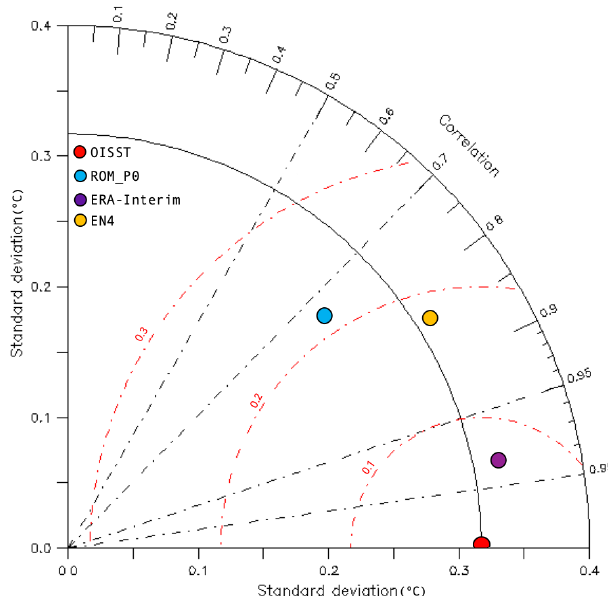
Figure 8. Taylor diagram for Mediterranean SSTs during the 1982– 2012 period. The diagram summarizes the relationship between standard deviation ( ◦ C), correlation ( r ) and RMSE (red lines, ◦ C) for all datasets. The gridded OISST was employed as